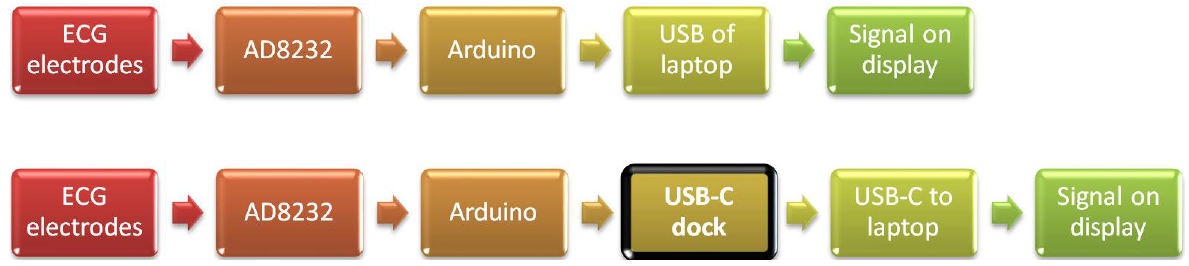
Figure 3. ECG measurement with a laptop working in battery mode ( upper process ) or with a laptop connected to the power grid by a common USB-C docking station ( lower process ).